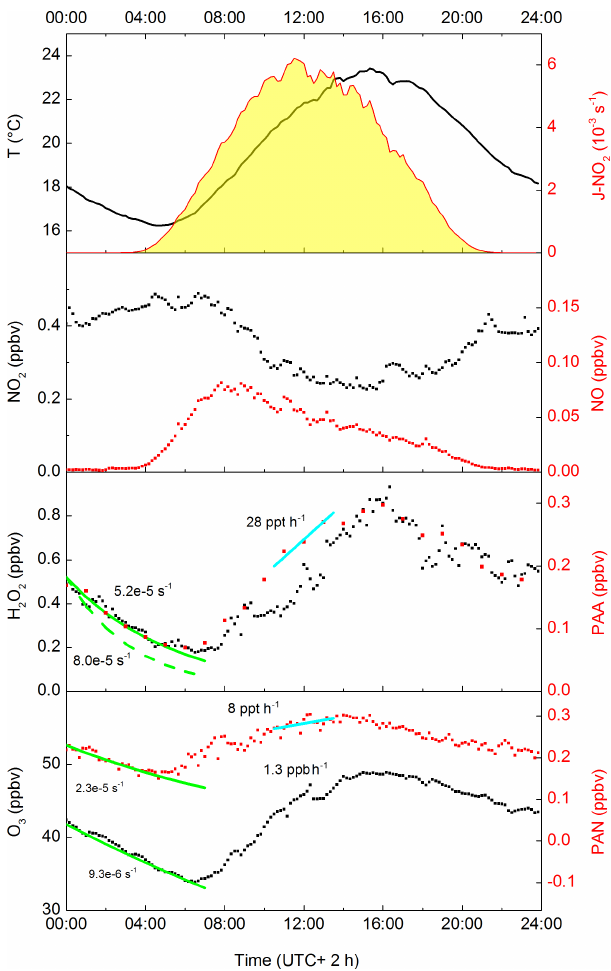
Figure 2. Averaged diel profiles (days 202–220) of PAN, O 3 , H 2 O 2 , NO 2 , NO, temperature, J -O( 1 D) (all 10min averages) and PAA (60min intervals). The solid green lines represent campaign- averaged, night-time exponential decay rate constants (s − 1 ) for H 2 O 2 , PAA, PAN and O 3 . The dashed green line is the adjusted decay constant for H 2 O 2 that takes into account its formation via ozonolysis of VOCs. The cyan lines represent average production rates (ppbv or pptv per hour) for PAA and PAN (centred at 12:00).